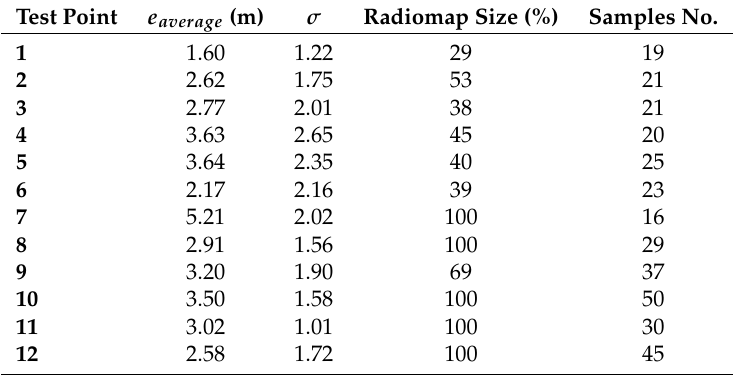
Positioning error of combined BLE (single BLE) and Wi-Fi RSS fingerprint-based positioning system.